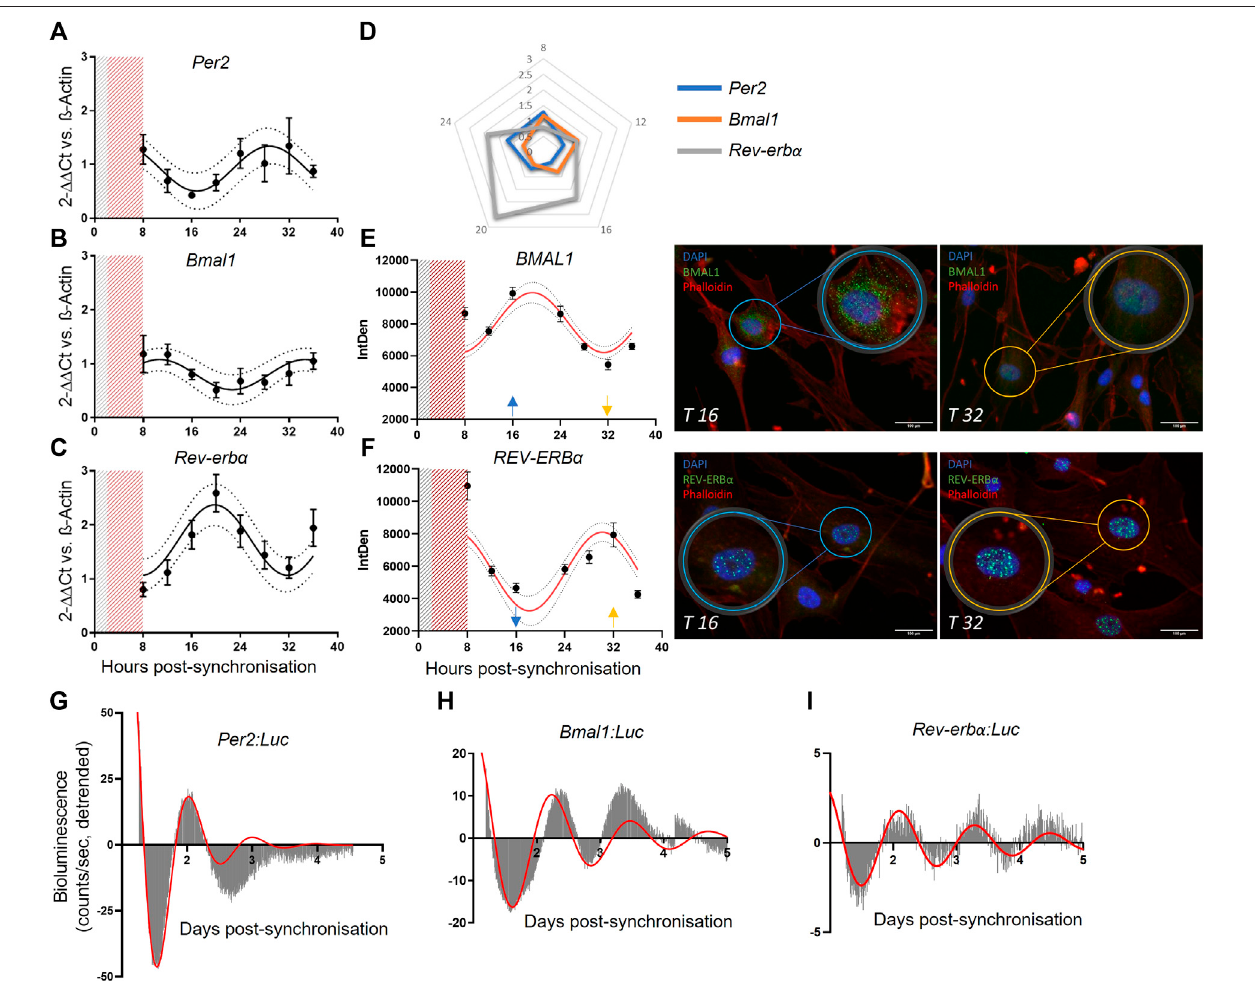
FIGURE 1 | Saphenous vein derived pericytes (SVP) possess an endogenous molecular clock. mRNA expression of Per2 (N = 3, (A) ), Bmal1 (N = 3, (B) ) and Rev- erb α (N=3, (C) ),inSVPcells.Dataispresentedas2 − ΔΔ Ct andnormalizedon β -actinhousekeepingmRNAexpression.ErrorbarsrepresentSEMand95%CIisshownin the graph. Non-linear regression (Cosinor Curve) is over-imposed and favorably compared against straight line. Radar graph denoting the peak of mRNA expression of each gene over 24 h (D) . Immuno fl uorescence representative images (T16 and T32) and integrated density quanti fi cation of nuclear signal intensity of proteins BMAL1 (N=3, (E) )andREV-ERB α (N=3, (F) ).Errorbarsrepresent SEMand95%CIareshowninthegraph.Non-linear regression(CosinorCurve, fi xedperiodof24 h) is over-imposed and favorably compared against straight line (p < 0.05). DAPI blue, Phalloidin red, BMAL11/REV-ERB α green, scale bar: 100 µm. Average detrended oscillatory pro fi le of serum shock synchronized SVP cells transduced with Per2:Luc (N = 2, (G) ) Bmal1:Luc (N = 2, (H) ) or Rev-erb α :Luc (N = 2, (I) ) lentivectors. Red line represents a damped sin wave with a period of 24 h.